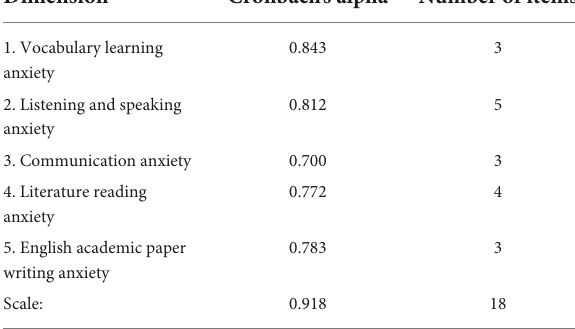
TABLE 1 Scale reliability